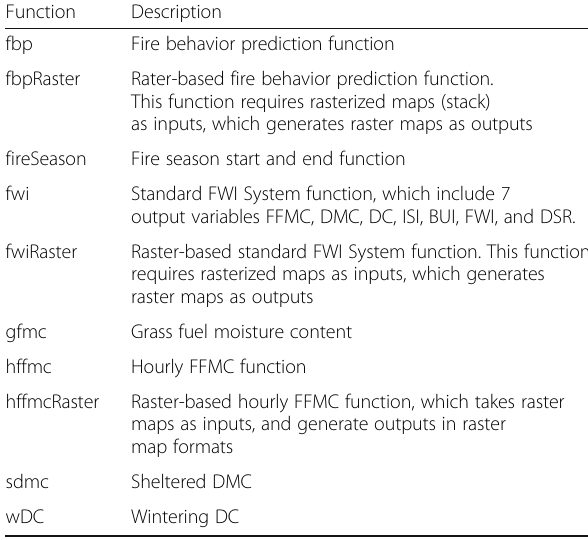
Table 1 cffdrs package functions and their